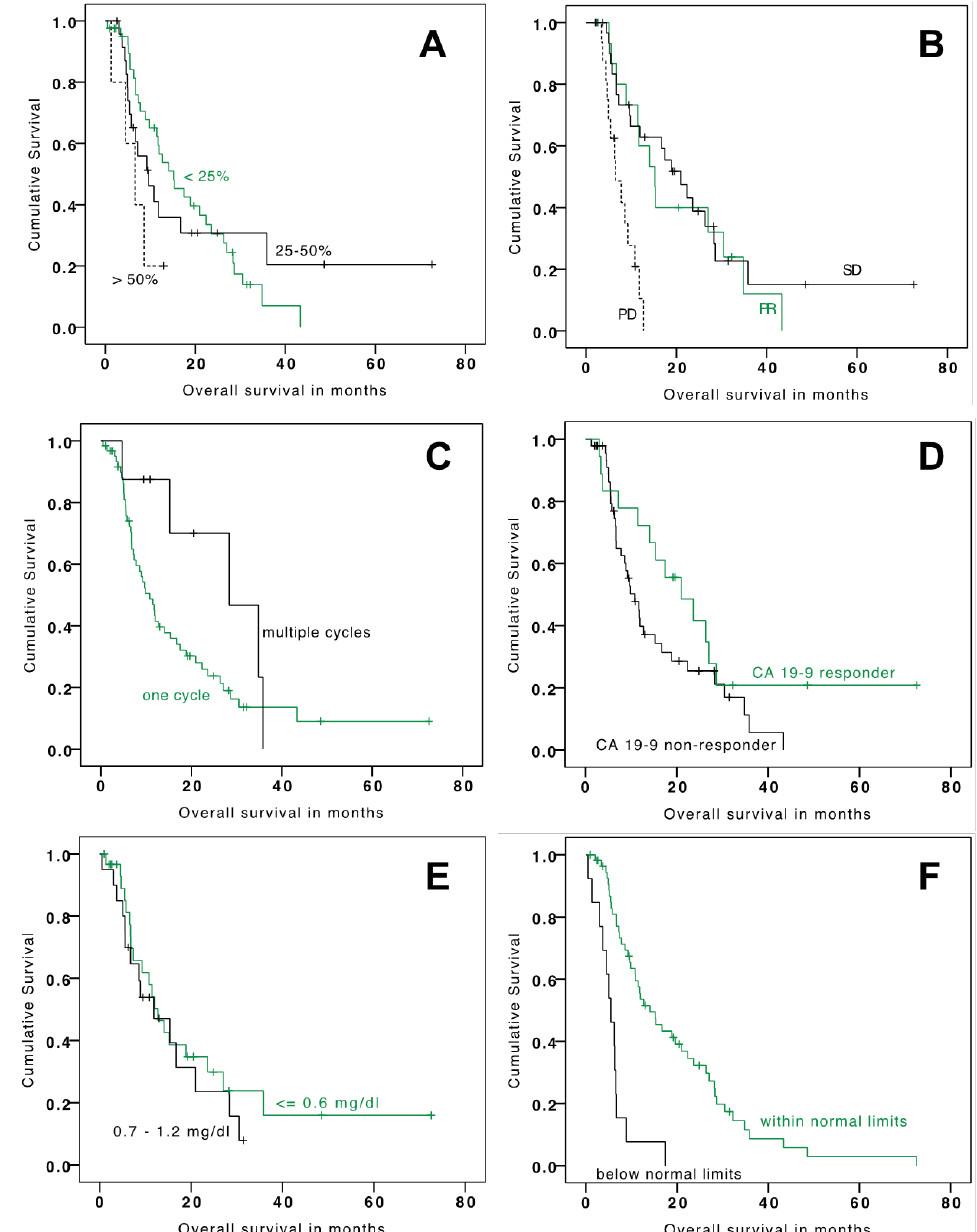
Figure 2. Kaplan–Meier analysis for overall survival stratified by tumor burden at baseline ( A ), RECIST response ( B ), number of treatment cycles ( C ), CA19-9 response ( D ), baseline levels of bilirubin ( E ), and baseline levels of cholinesterase ( F ). Table 3. Median OS and PFS in months.